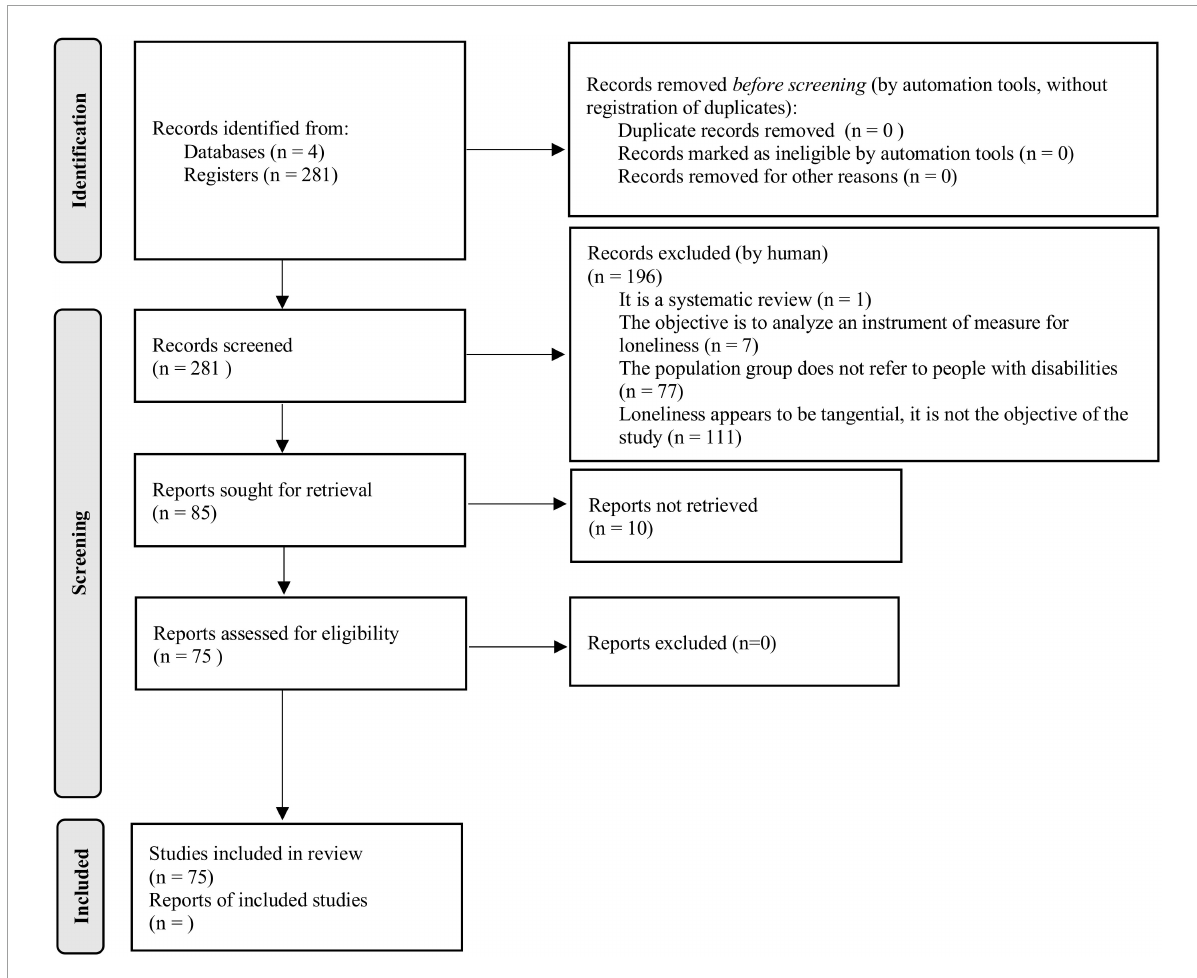
FIGURE1 Flow chart of identification, screening, and inclusion process. Duplicates = 0 because the database search tools automatically remove